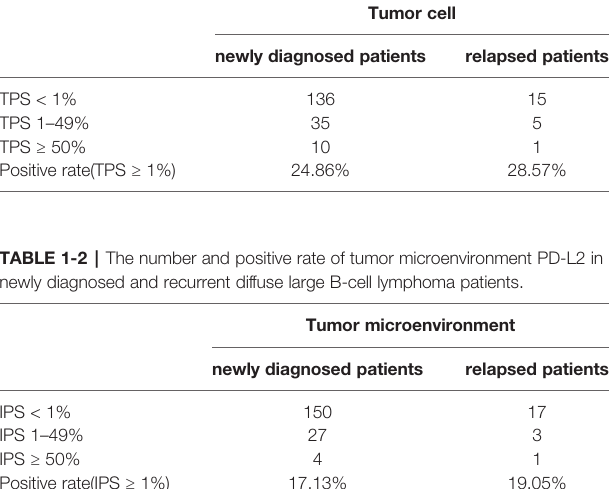
TABLE 1-1 | The number and positive rate of tumor cell PD-L2 in newly diagnosed and recurrent diffuse large B-cell lymphoma patients. Tumor cell